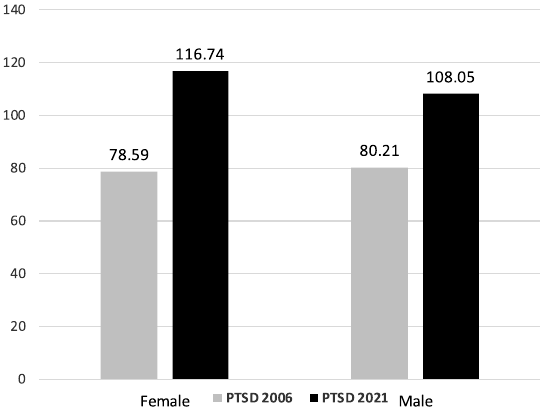
Fig. 2 Effect of gender on PTSD symptoms in 2006 and